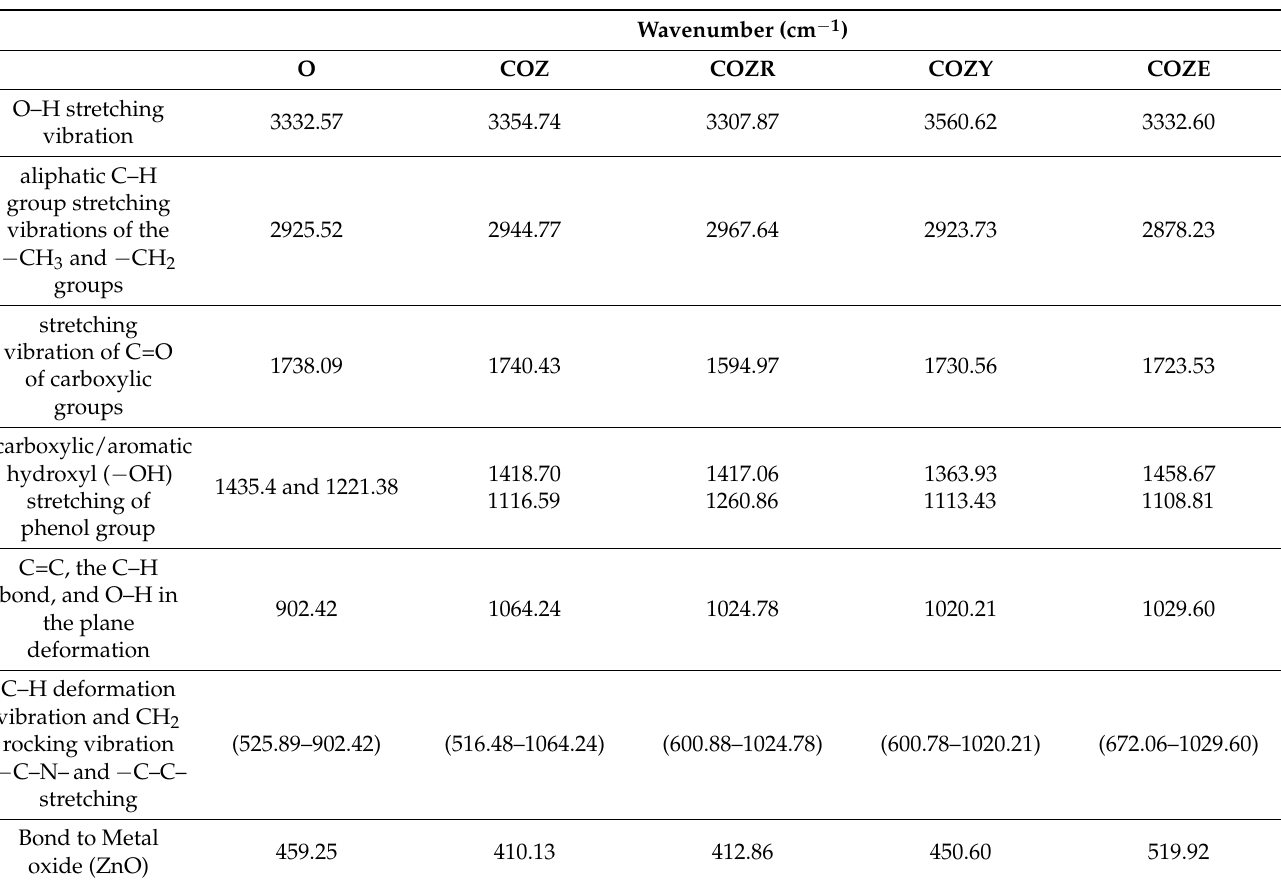
Figure 1. FT-IR analysis of ( a ) raw oak cupules powder and ( b ) coated oak cupules powder with ZnO [COZ]; ( c ) red hair dye onto COZ [COZR], ( d ) Yellow hair dye onto COZ [COZY], and ( e ) Ebony dye onto COZ [COZE]. Table 1 FT-IR results for all samples of O , COZ , COZR , COZY , and COZE : Table 1. FTIR Results.